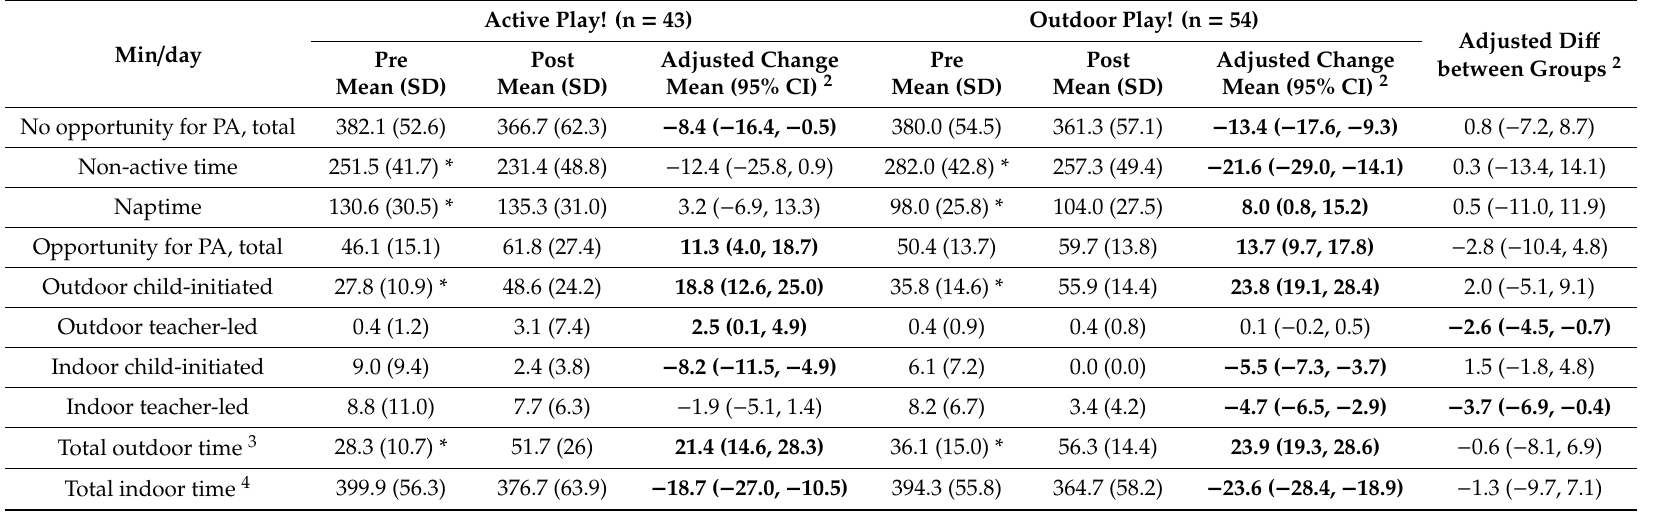
Table 4. Comparison of direct observation 1 variables by intervention